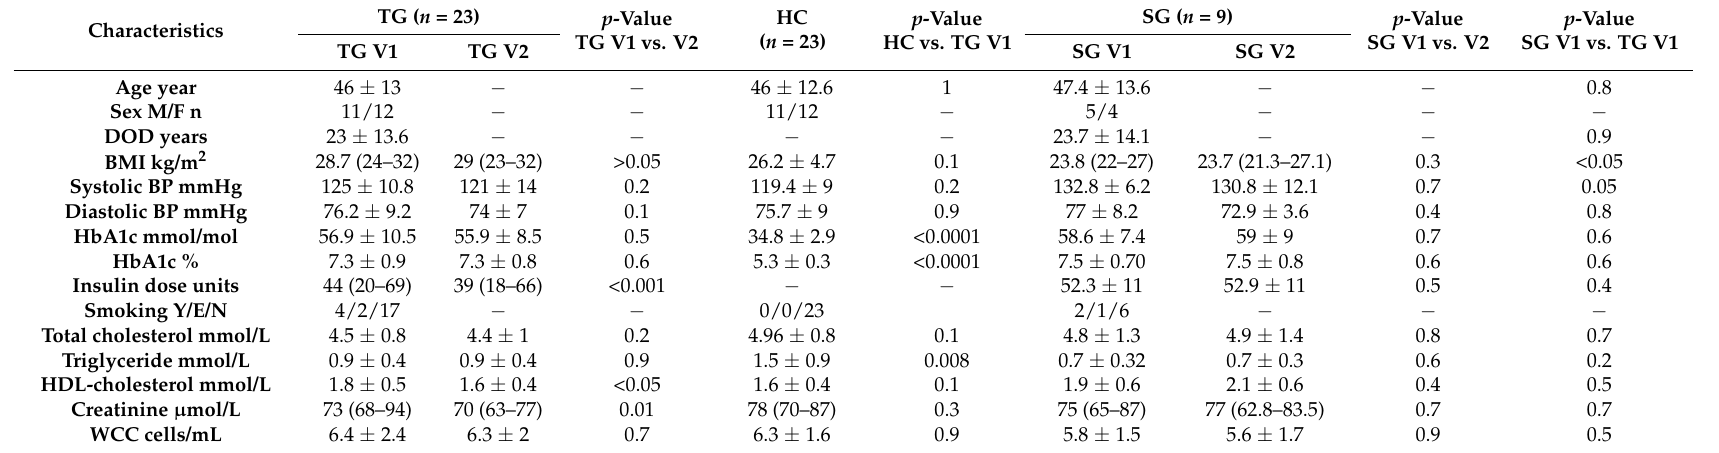
Table 1. Subjects’ clinical and metabolic